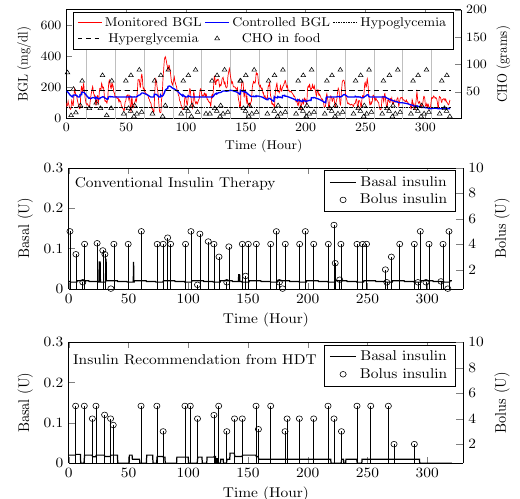
Figure 24. Insulin recommendation and BGL for P 1 —Top panel shows the comparison between uncontrolled BGL variations during the clinical trial and controlled BGL using HDT framework. The middle plot shows insulin infusion during the clinical trial, whereas insulin recommendation from HDT is shown in the bottom